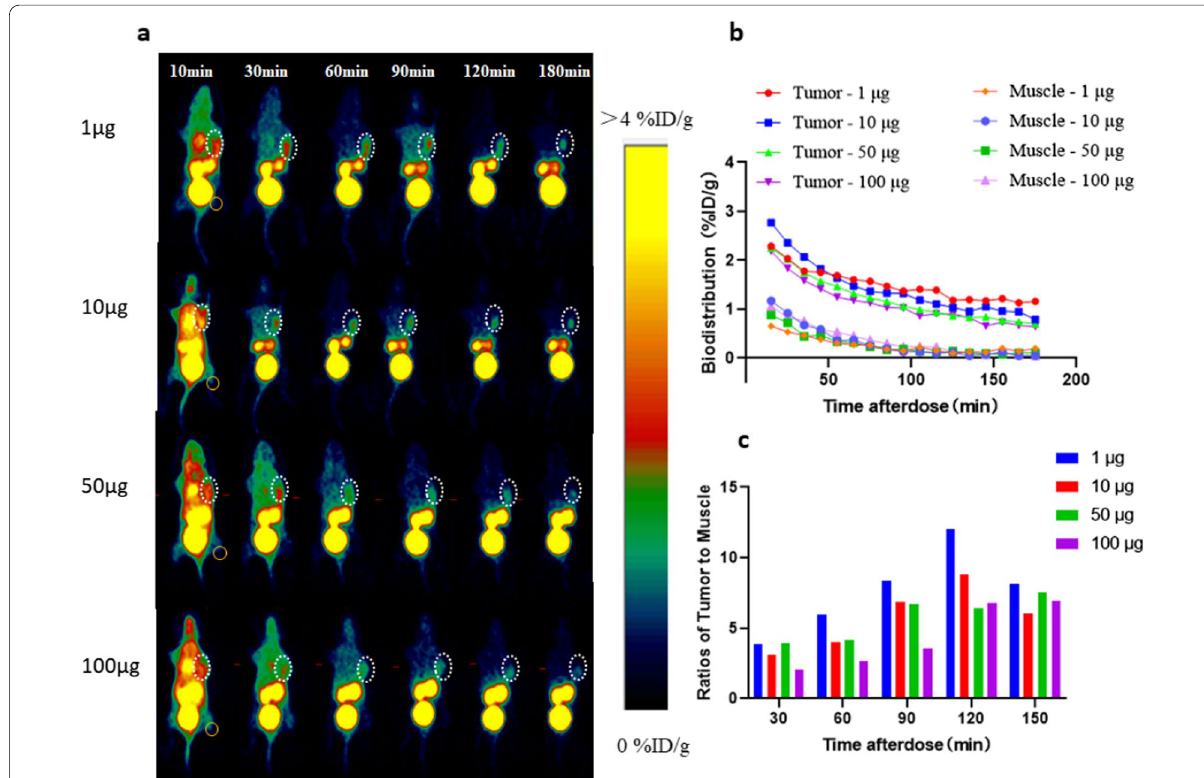
Fig. 3 a Dynamic micro-PET imaging of 68 Ga-NOTA-Nb109 in C57-hPD-L1 tumor-bearing transgenic mice over 0–3 h. b Biodistribution data of 68 Ga-NOTA-Nb109 in the tumor and muscles were analyzed by quantification analysis of PET image. c The Tumor-to-muscle (T/M) ratio of 68 Ga-NOTA-Nb109 was analyzed by quantification analysis of PET image. The white dotted circle indicates the tumor. The orange circle indicates the muscle